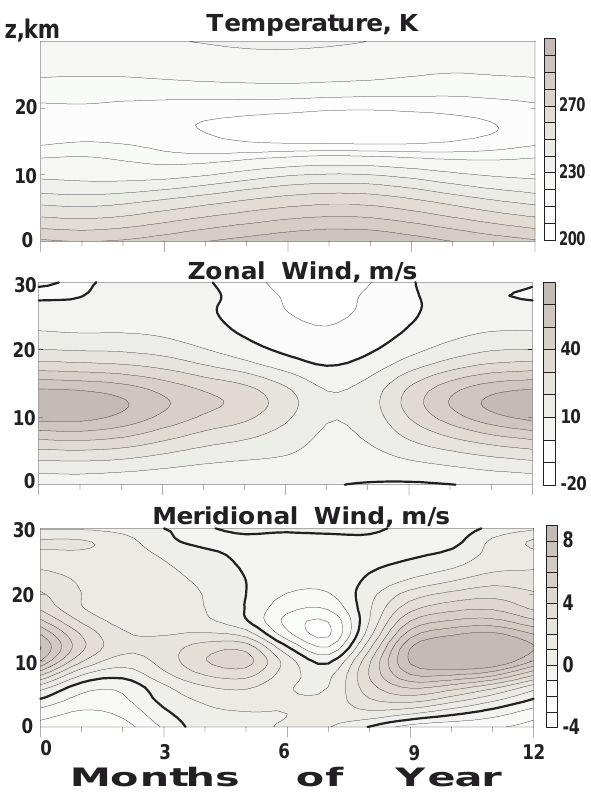
Fig. 2. Background temperature (top), and zonal (middle) and meridional (bottom) wind velocities at Shigaraki,